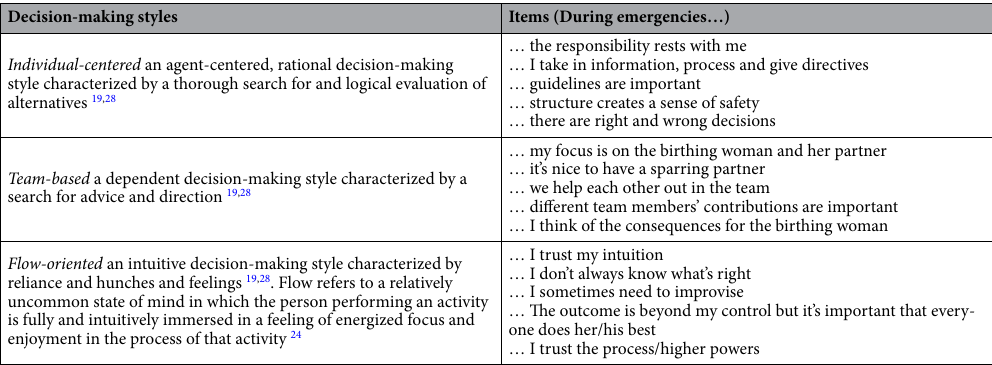
Table 1. Three decision-making styles during childbirth emergencies. Items refer to question 23.1–23.15 in the questionnaire.